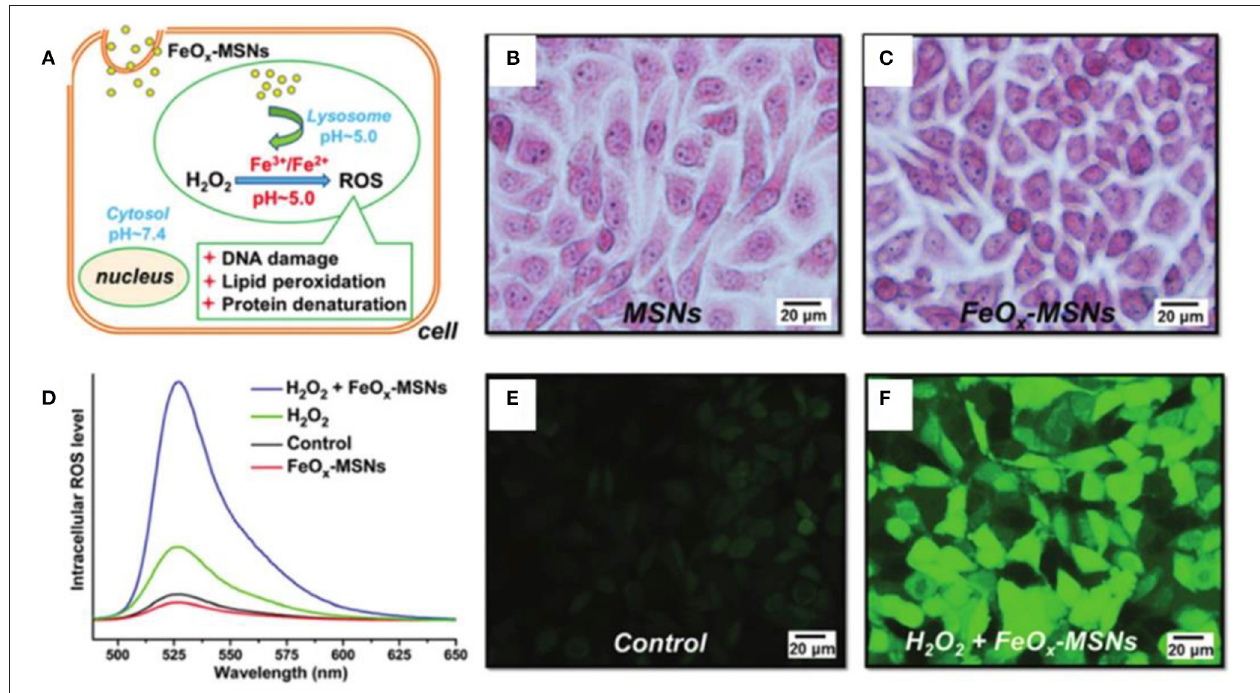
FIGURE 1 | (A) Illustration of interactions of FeO x -MSNs and H 2 O 2 . Turnbull’s blue stain of ZR75-30 cells after incubation with (B) MSNs and (C) FeO x -MSNs. (D) Fluorescence emission spectra of DCF in ZR75-30 cells after incubation with FeO x -MSNs and/or H 2 O 2 . Fluorescence images of ZR75-30 cells in the (E) control and (F) FeO x -MSN plus H 2 O 2 groups. Reproduced, with permission, from Fu et al. (2015). Copyright 2015, Royal Society of